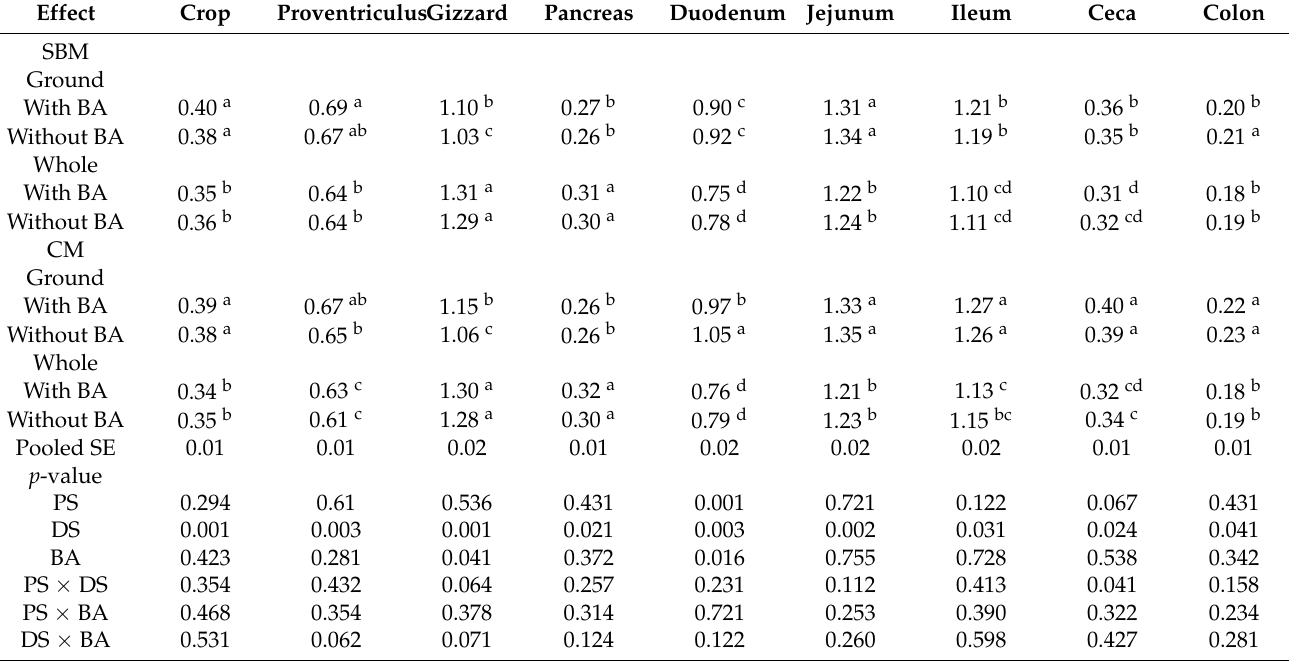
Table 3. Effect of protein source (PS), diet structure (DS) and butyric acid (BA) supplementation on empty relative weight (g/100 g of BW) of different intestinal segments and associated organs in broilers 1 at 36 days of